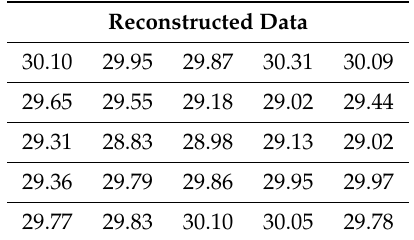
Table 14. Table of reconstructed data.